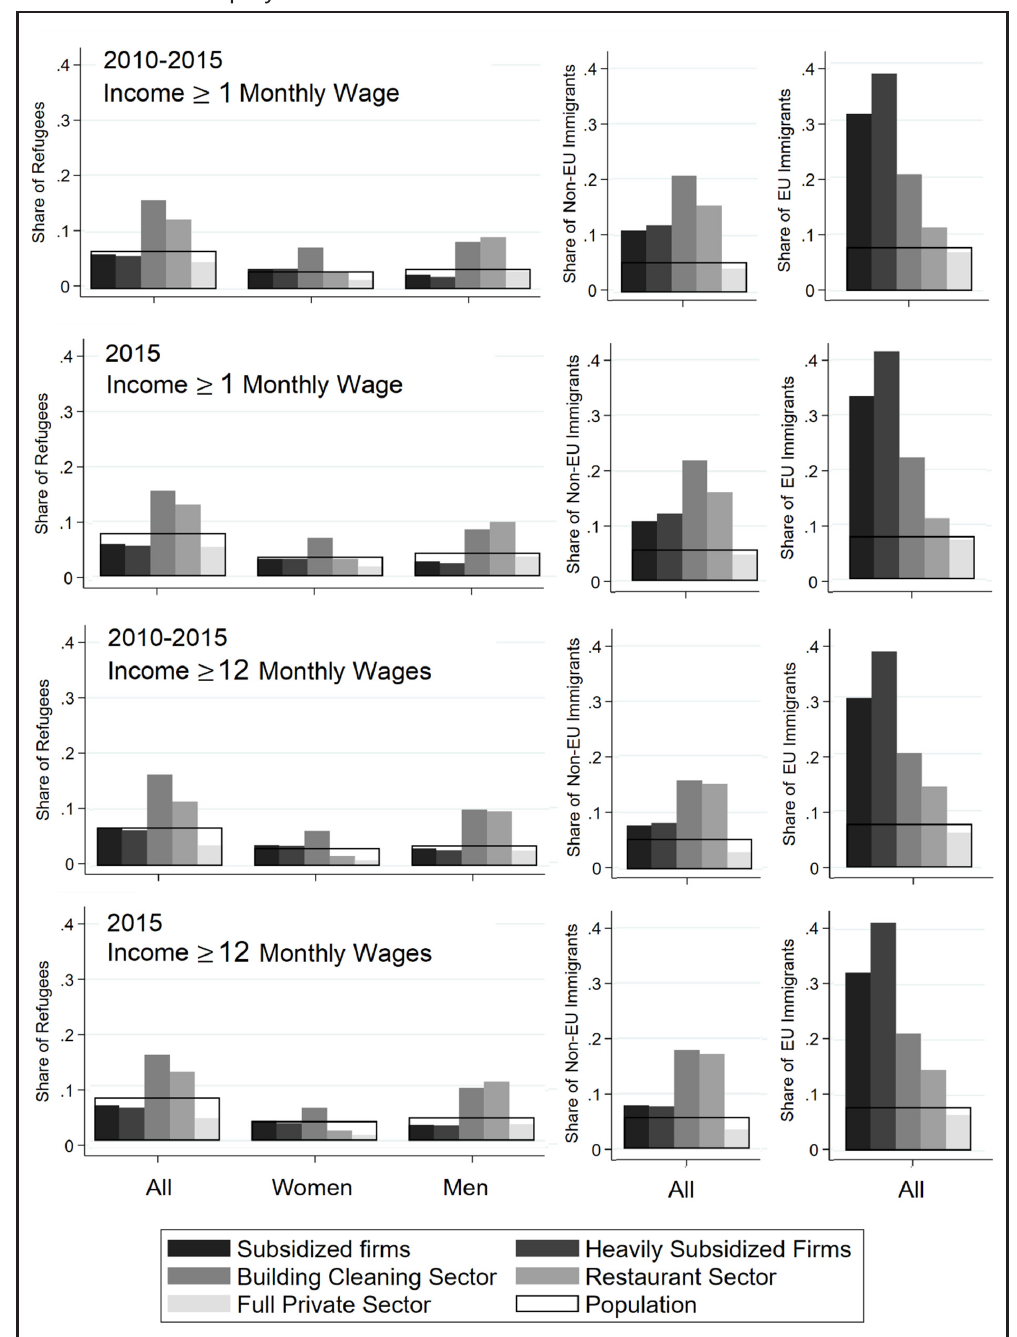
Figure W7 Composition of immigrants across sectors at two alternative income thresholds for